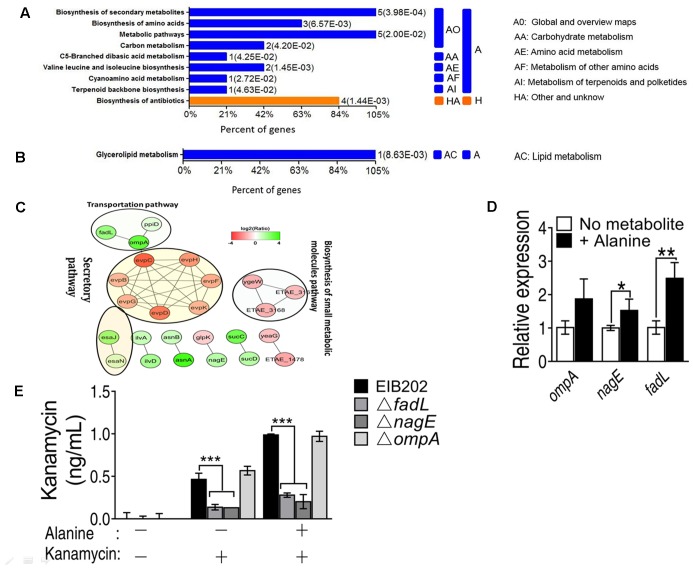
KEGG pathway enrichment of metabolic pathway shows (A) up and (B) down regulated proteins in the presence of exogenous alanine; (C) STRING software prediction of the protein–protein interaction pathways induced by alanine (including the secretory pathway, transportation pathway and biosynthesis of small metabolic molecules pathway); (D) QRT-PCR validation of the expression of three outer membrane proteins, OmpA, NagE and FadL; (E) Quantification of intracellular concentration of kanamycin in EIB202, or fadL, nagE and ompA single deletion mutants. ∗p < 0.05, ∗∗p < 0.01, and ∗∗∗p < 0.001 as determined by Student’s t-test.